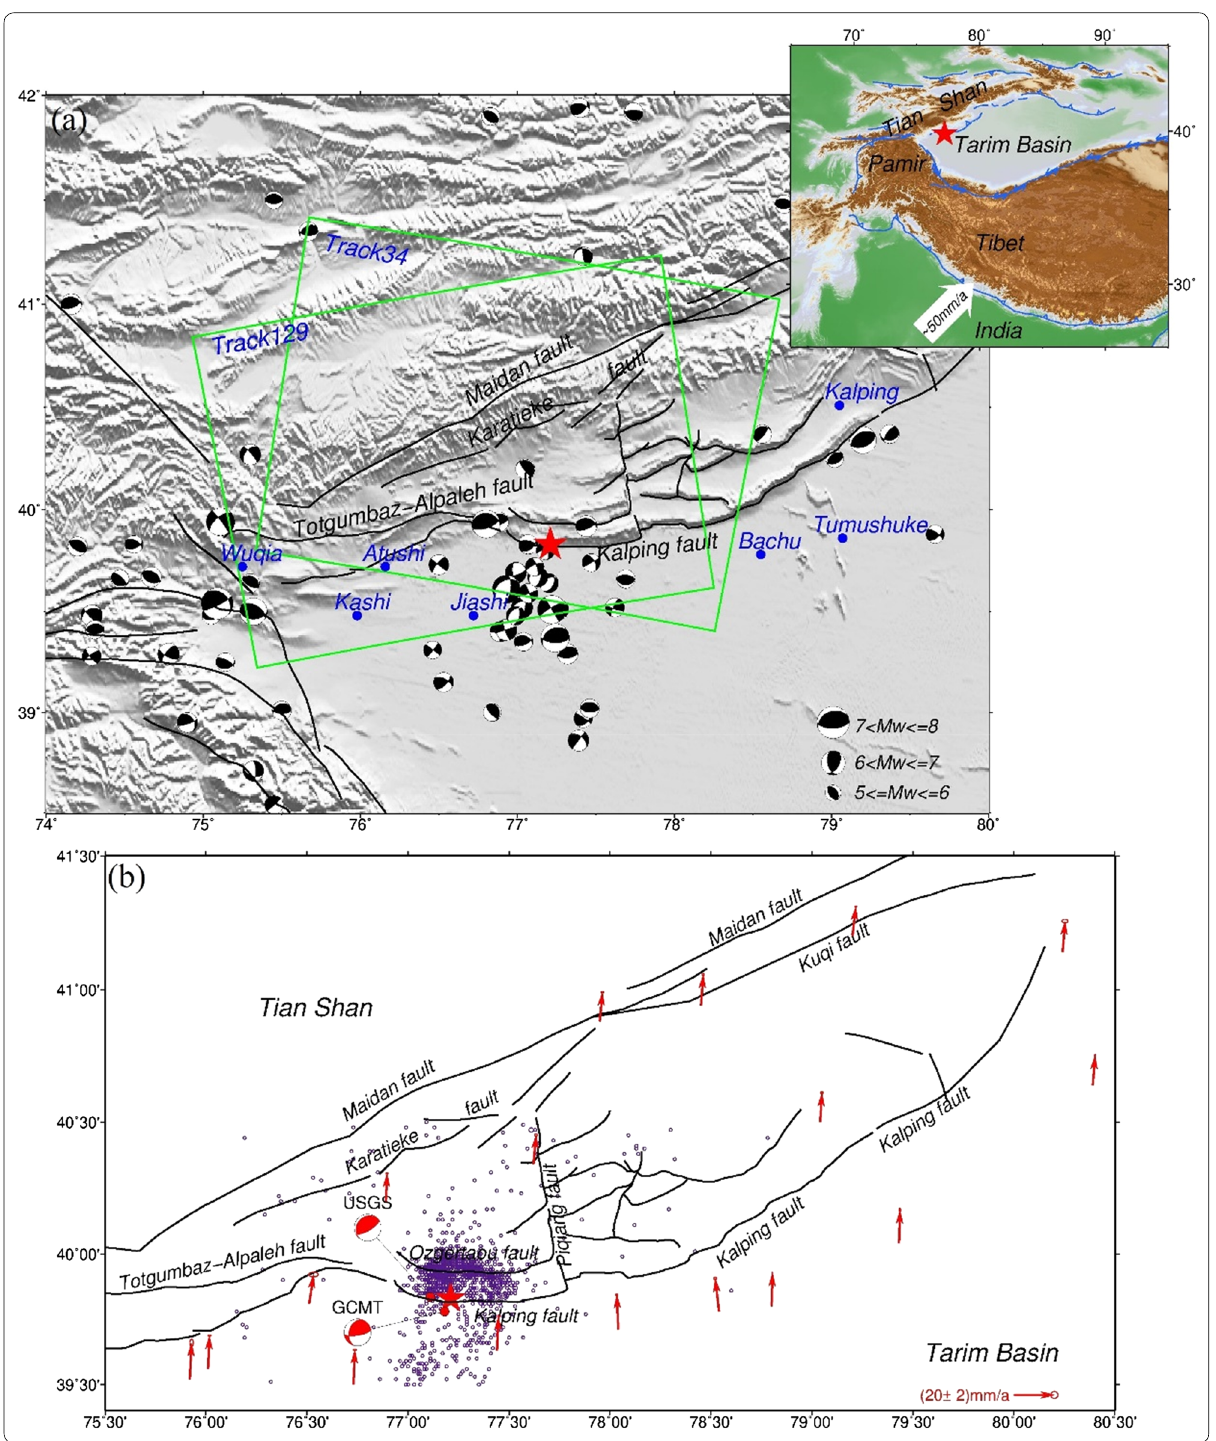
evaluated and the potential seismic hazards are analyzed in the study